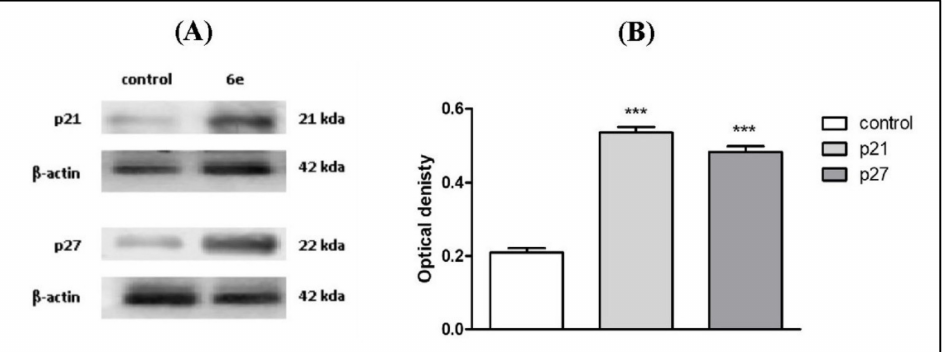
Figure 5. Effect of compound 6e on cell-cycle regulatory proteins p21 and p27 in MCF-7 cells treated with IC 50 , 1.67 µ M for 48 h measured by western blot. ( A ) One of three repeated experiments is shown. ( B ) Bar chart represents the quantification of the protein expression level of p21 and p27 compared to control. *** Significantly different from control at p <